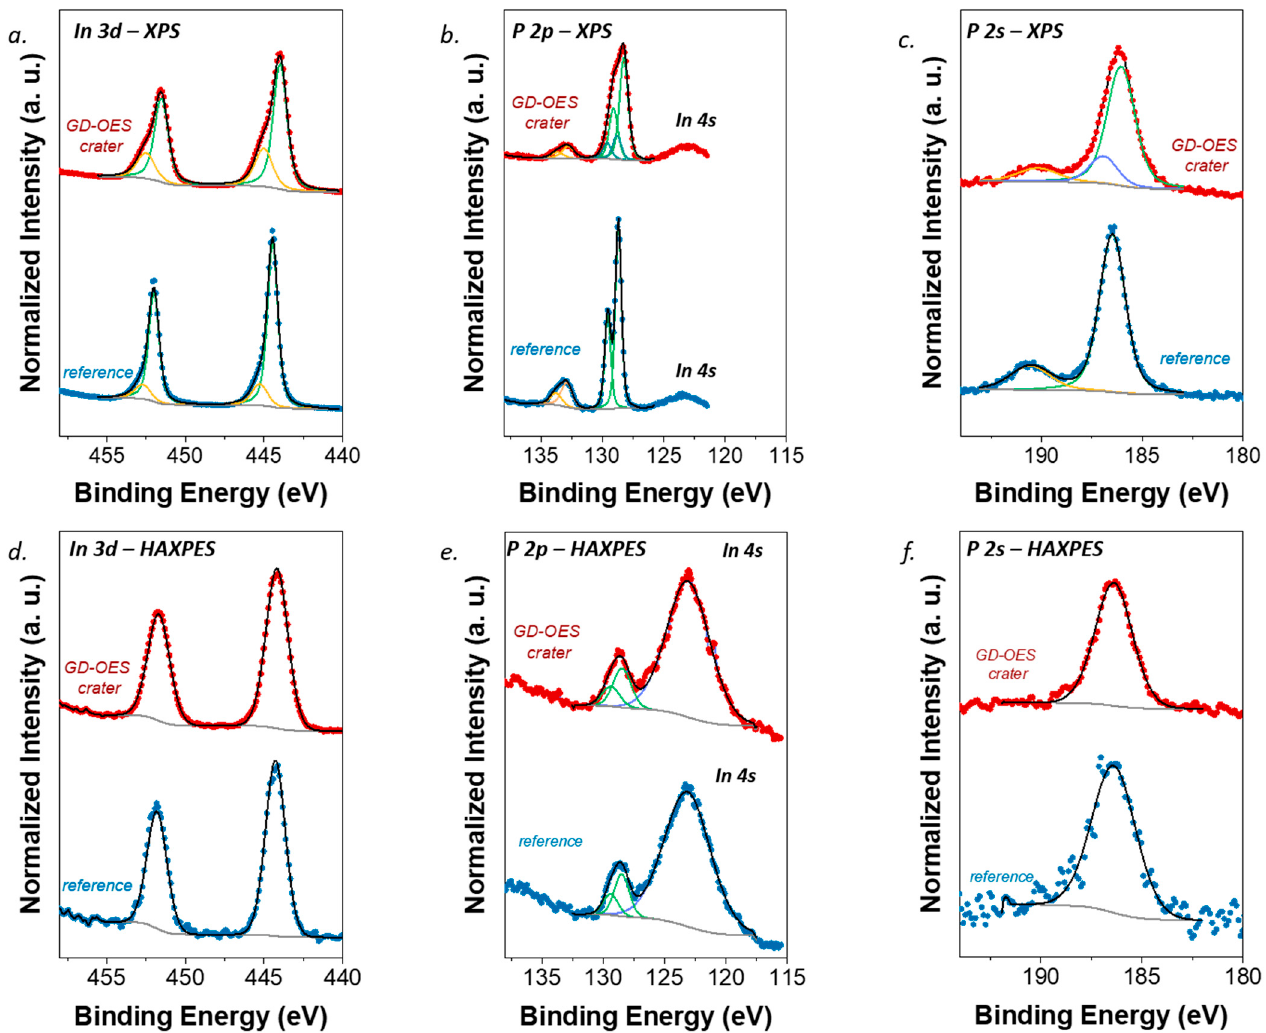
Figure 3. In 3d, P 2p and P 2s high energy resolution spectra for the InP surface outside (blue, bottom spectra) and inside (red, top spectra) the GD crater measured with Al-K α (1.49 keV) ( a – c ) and Ga-K α (9.25 keV) ( d – f ) sources. The fitting reconstruction with oxide (orange) and matrix (green) contributions is represented.